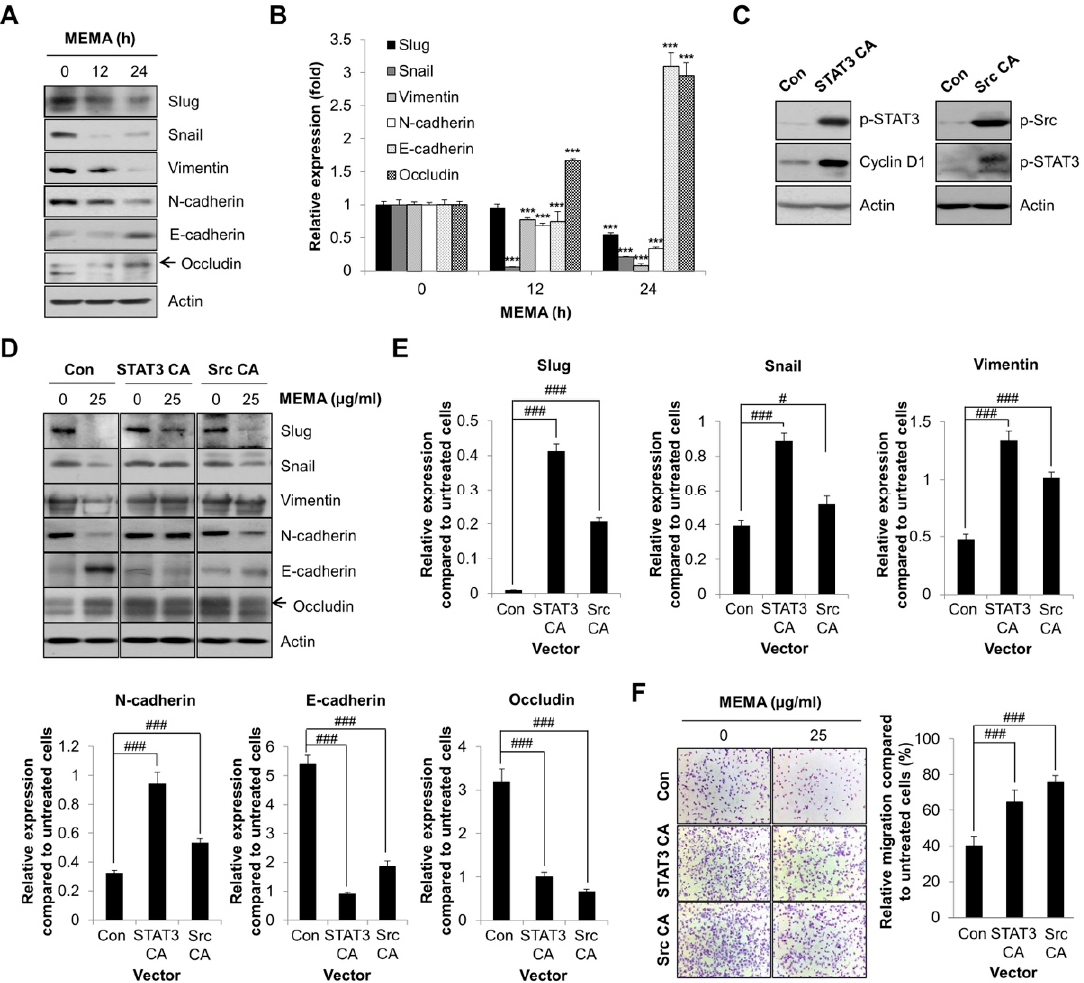
Figure 6. Influence of Src and STAT3 on the regulation of EMT and migration in H1299 cells. ( A , B ) H1299 cells were treated with MEMA (25 µ g / mL) for 12 or 24 h. The expression levels of EMT marker proteins were assessed by Western blot analysis. ( A ) The representative gel images are shown. ( B ) The relative expressions of the indicated proteins were calculated using Image J software. Actin was used for normalization. ( C – E ) H1299 cells were transfected with STAT3 CA or Src CA. ( C ) At 48 h post-transfection, the expression levels of the indicated proteins were assessed by Western blot analysis. ( D , E ) At 24 h post-transfection, cells were treated with MEMA (25 µ g / mL) for 24 h. The expression levels of EMT marker proteins were assessed by Western blot analysis. ( D ) The representative gel images are shown. ( E ) The relative expressions of the indicated proteins were calculated using Image J software. Actin was used for normalization. ( F ) H1299 cells transfected with either STAT3 CA or Src CA were plated into the gelatin-coated upper chambers of transwell plate and treated with MEMA (25 µ g / mL). 10% FBS medium was used as a chemoattractant. After 24 h of incubation, the migrated cells were stained and photographed under microscope (100 × magnification). The relative migration of MEMA-treated cells compared to that of untreated cells was calculated by counting the number of stained cells. The data are expressed as the mean ± S.D. of three independent experiments. Significance was determined by the Student’s t -test (*** p < 0.001 vs. untreated controls; # p < 0.05, ### p < 0.001 versus respective control). Con, control vector; STAT3 CA, constitutively active STAT3 (Y705D) vector; Src CA, constitutively active Src (Y527F)